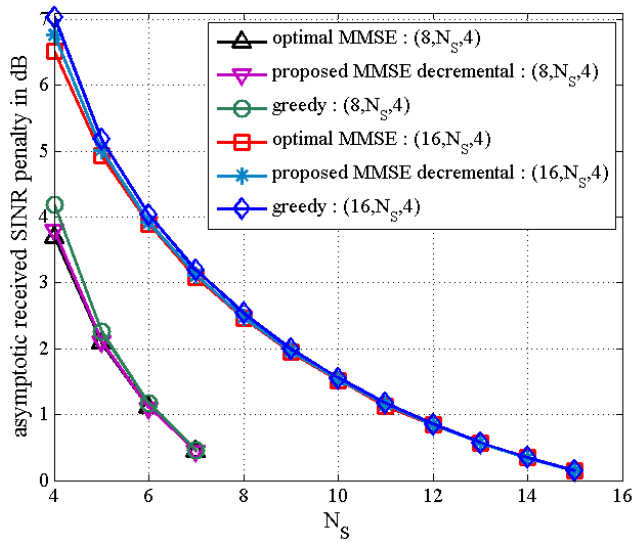
Figure 7. Received signal-to-interference-plus-noise ratio (SINR) loss for MU–STLC system with TAS selection for ( 8, N S ,4 ) and ( 16, N S ,4 ) .